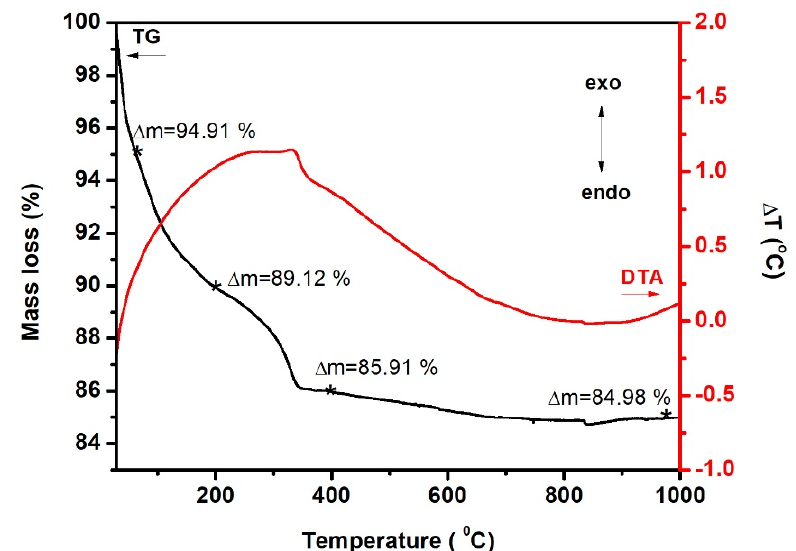
Figure 1. The TG and DTA curves for CoCr 2 O 4 dried gel.